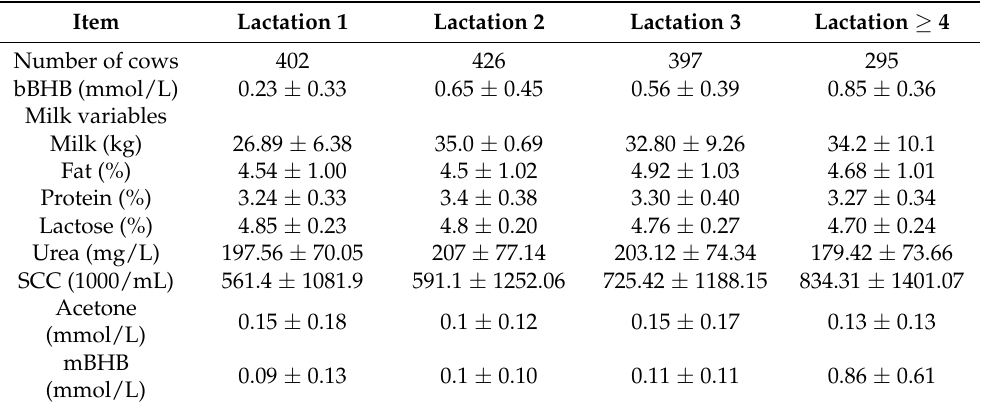
Table 1. Number of animals tested ( n = 1520), mean and standard deviation of milk variables and β -hydroxybutyrate concentration (bBHB) in blood and milk (mBHB) according to lactation